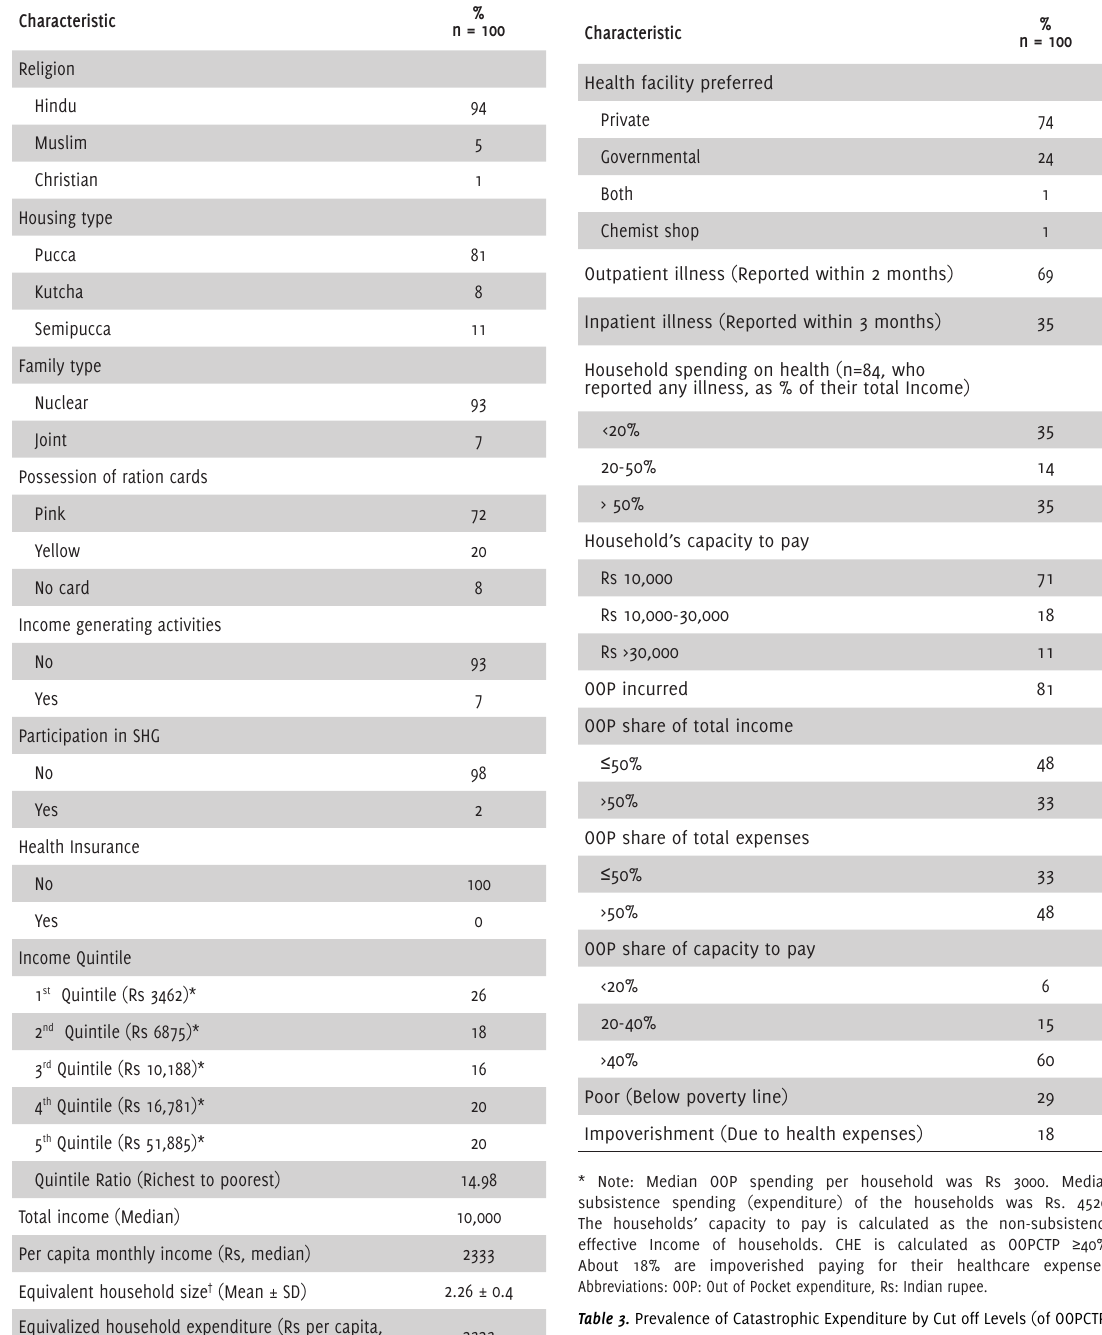
Table 2. Reported illness, capacity to pay and consequence of health expen- ses incurred per households.